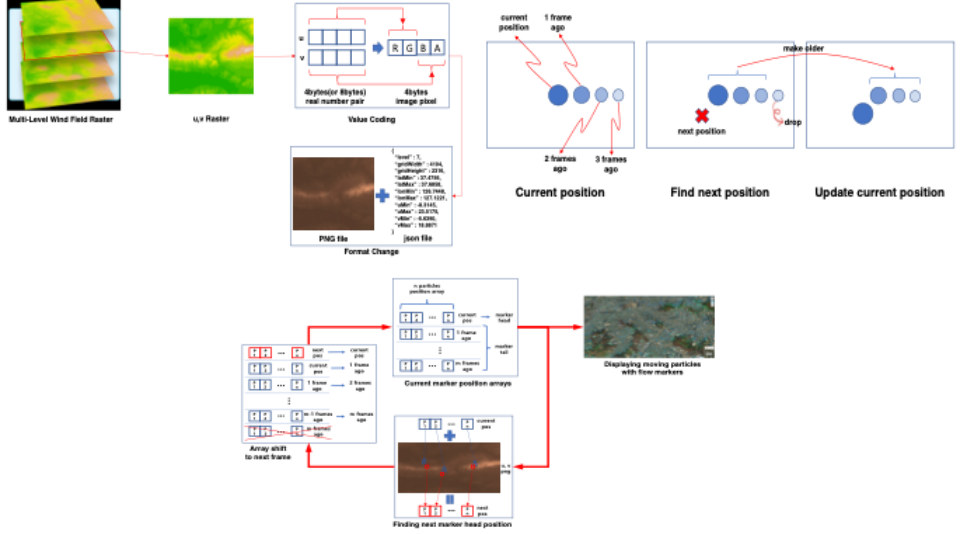
Figure 2. Raster data, the determination of wind flow markers, and the visualization of wind data .